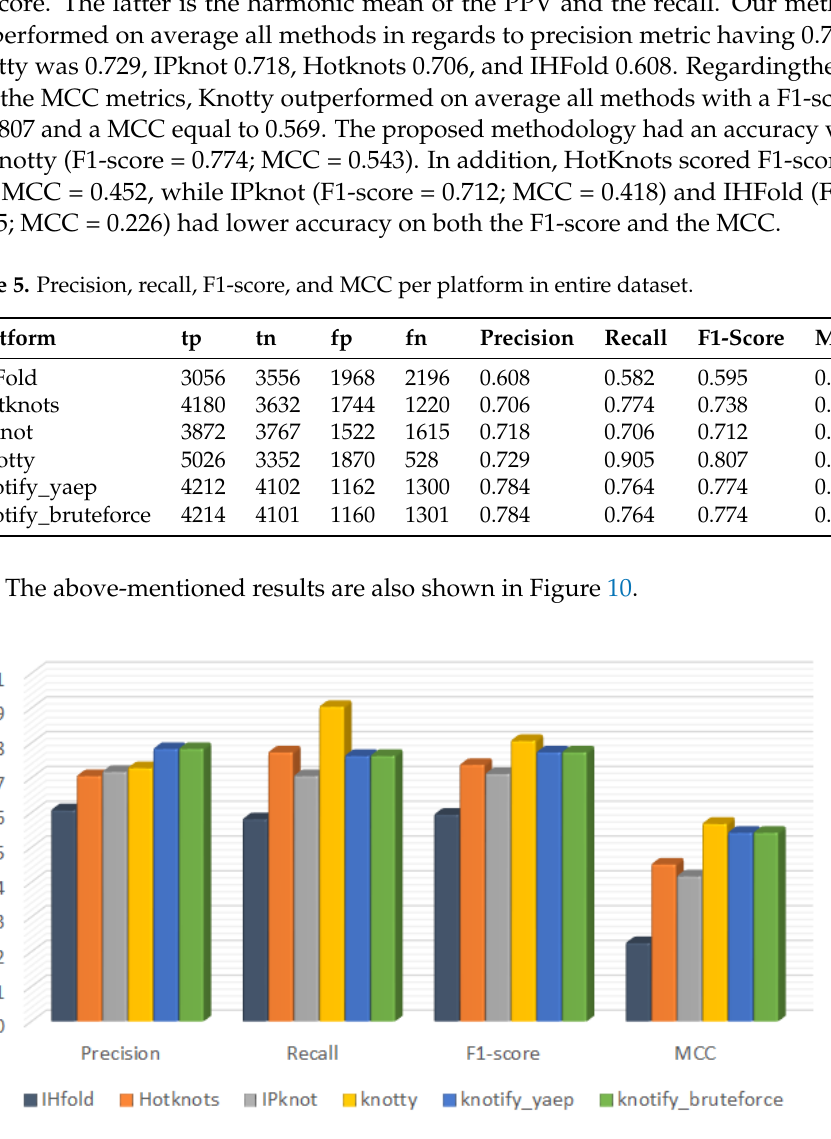
Figure 10. Precision, recall, F1-score, and MCC per